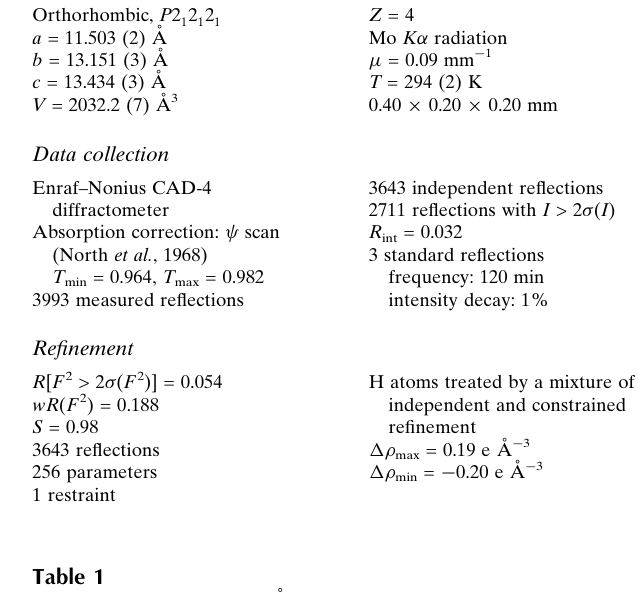
Hydrogen-bond geometry (A˚ , (cid:4)